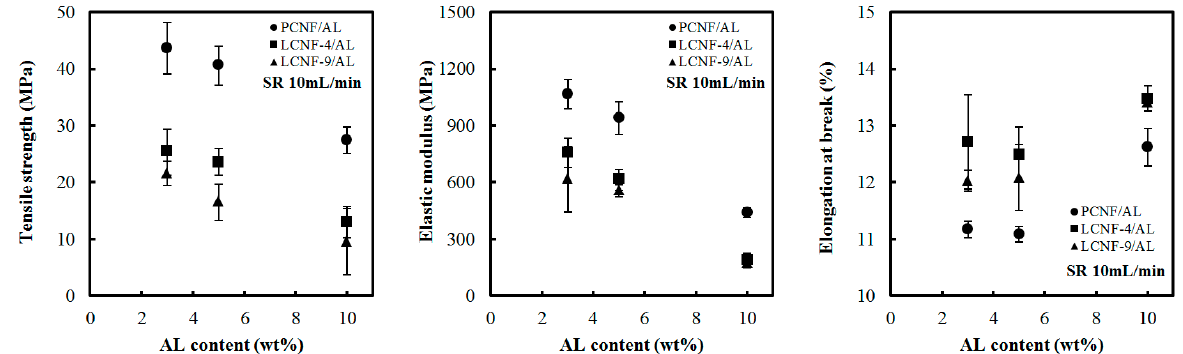
Figure 8. Tensile strength, elastic modulus, and elongation at break of wet-spun composite filament from PCNF/AL, LCNF-4/AL, and LCNF-9/AL with different AL content (spinning rate: 10 mL/min).